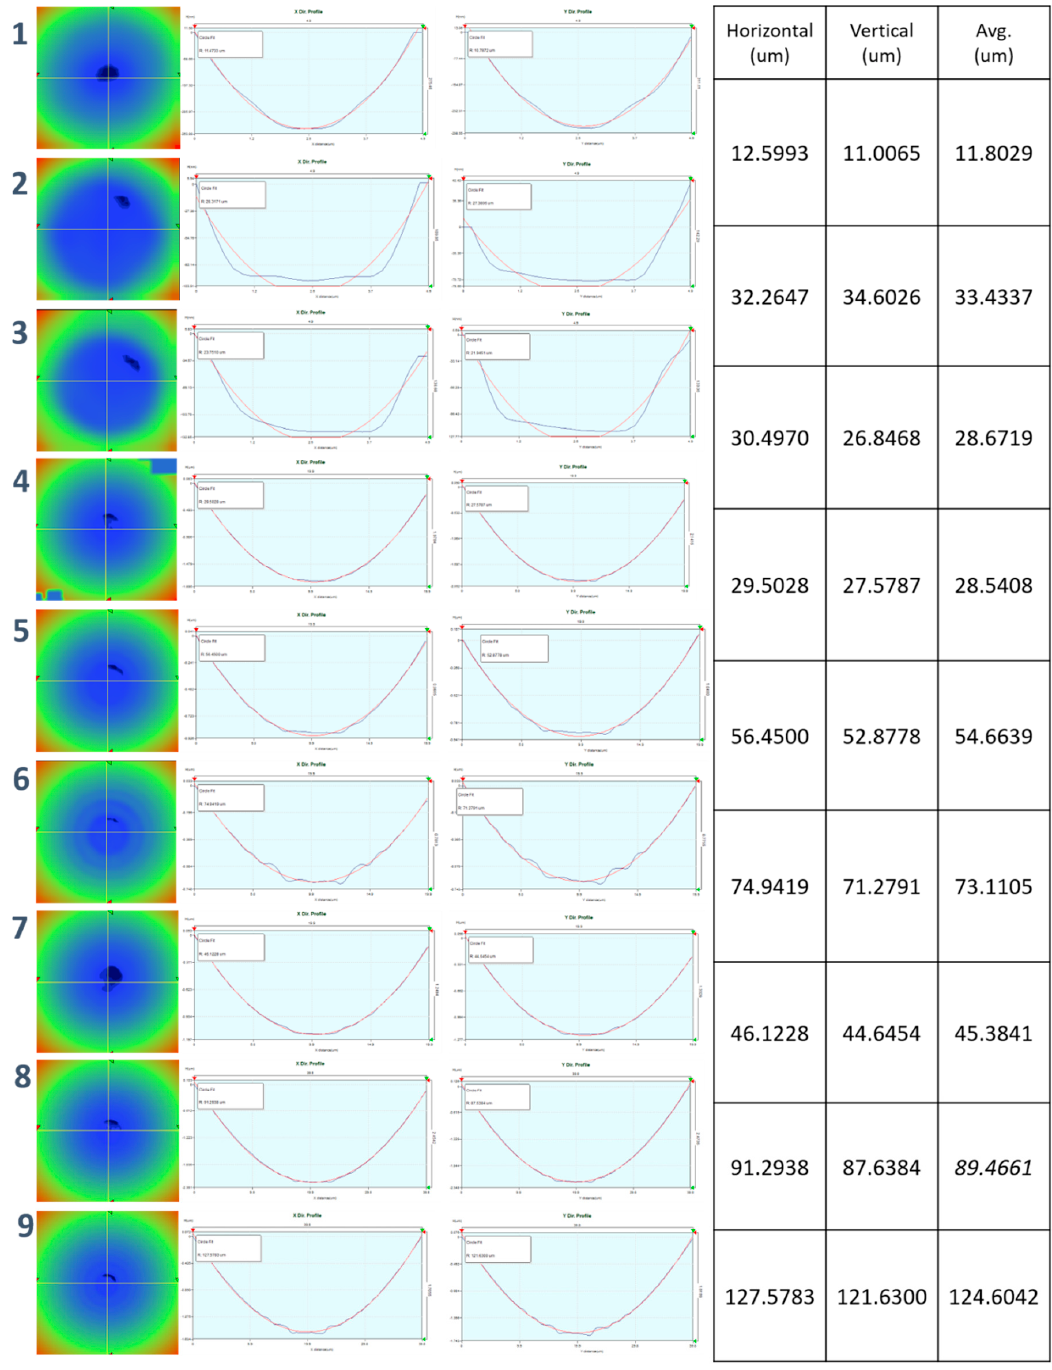
Figure A20. ROC measurement data for 5th final product replica (OrmoClear FX).